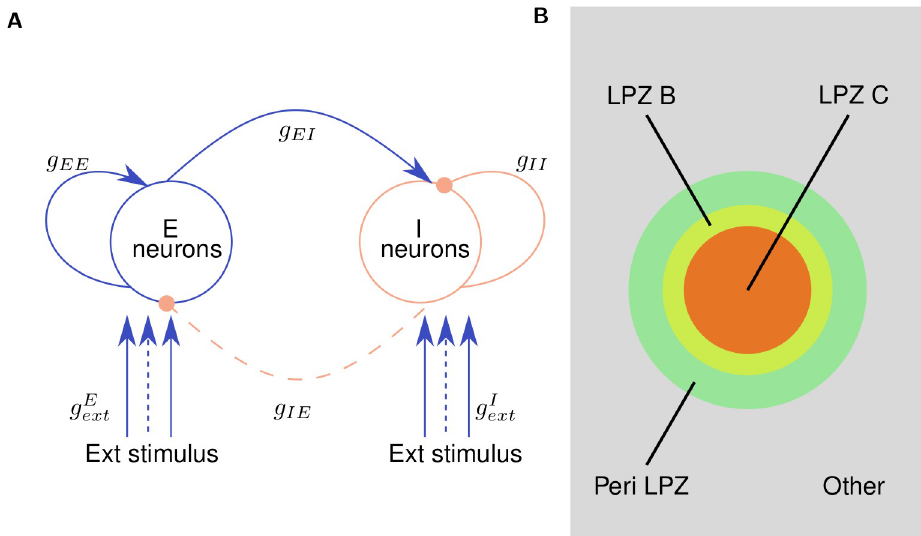
= 4 N (see Methods)) are initially E I , g , g , EE EI II and g I , respectively. To ext Inh